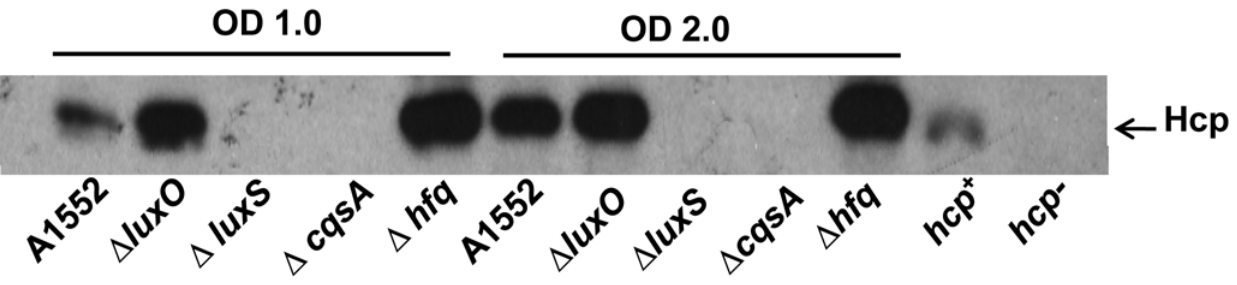
Figure 4. Hcp levels in different quorum sensing regulatory system of V.cholerae strain A1552. The samples were taken at OD 1.0 and OD 2.0 from wild type V. cholerae O1 strain A1552 and its quorum sensing regulator mutants and immunoblot analyses were done using anti-Hcp